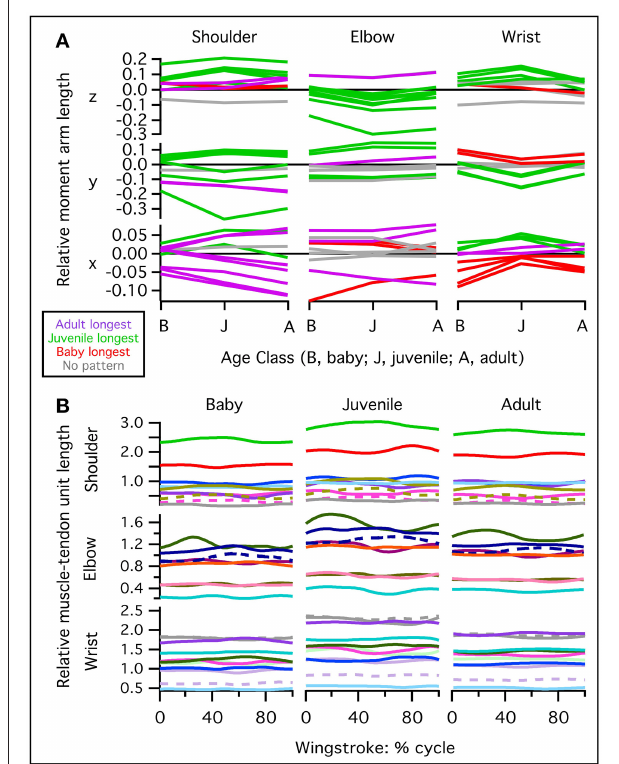
FIGURE 9 | Normalized muscle moment arms and lengths. The juvenile model tends to have relatively long moment arms and muscle lengths compared to the adult and baby models. (A) Moment arms for muscles crossing the shoulder, elbow, or wrist, averaged over the stroke cycle and standardized by notarium length. Different lines are for different muscles. Red lines: moment arm is greatest (most positive or most negative) in the baby model; green: moment arm is greatest in the juvenile model; purple: moment arm is greatest in the adult model; gray: no ontogenetic trend. The juvenile has proportionally long z (elevation-depression or extension-flexion) and y (protraction-retraction or abduction-adduction) moment arms, and the adult has long x (supination-pronation) moment arms at the shoulder. (B) Muscle-tendon unit (MTU) length through one wingbeat cycle (0–100%), standardized by notarium length; different colors represent different muscles crossing the shoulder, elbow, or